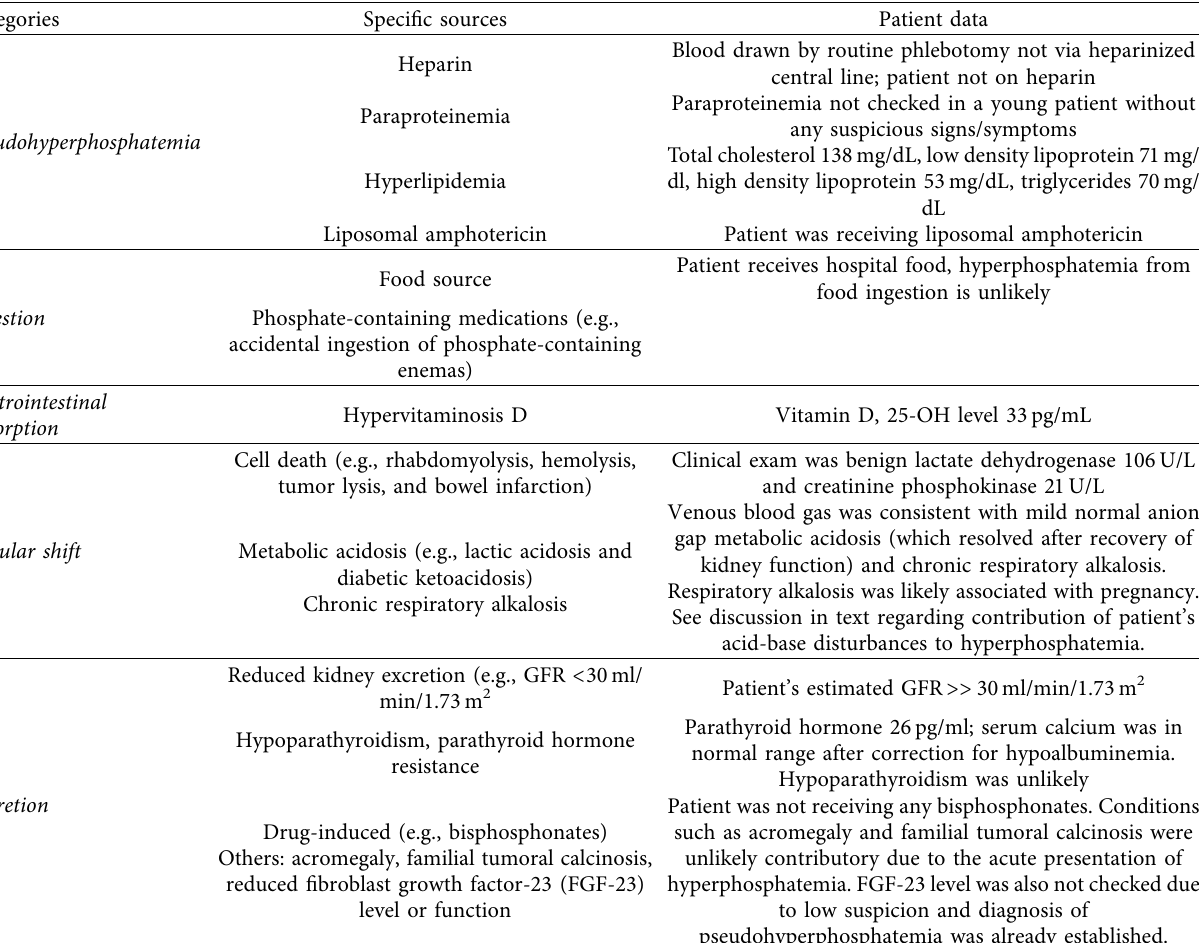
Table 2: Evaluation of hyperphosphatemia.